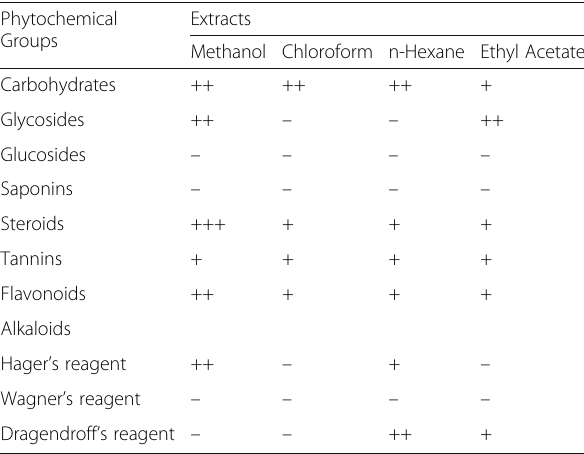
Table 1 Phytochemical Analysis of Different Fractionates of Cheilanthes tenuifolia Phytochemical Groups